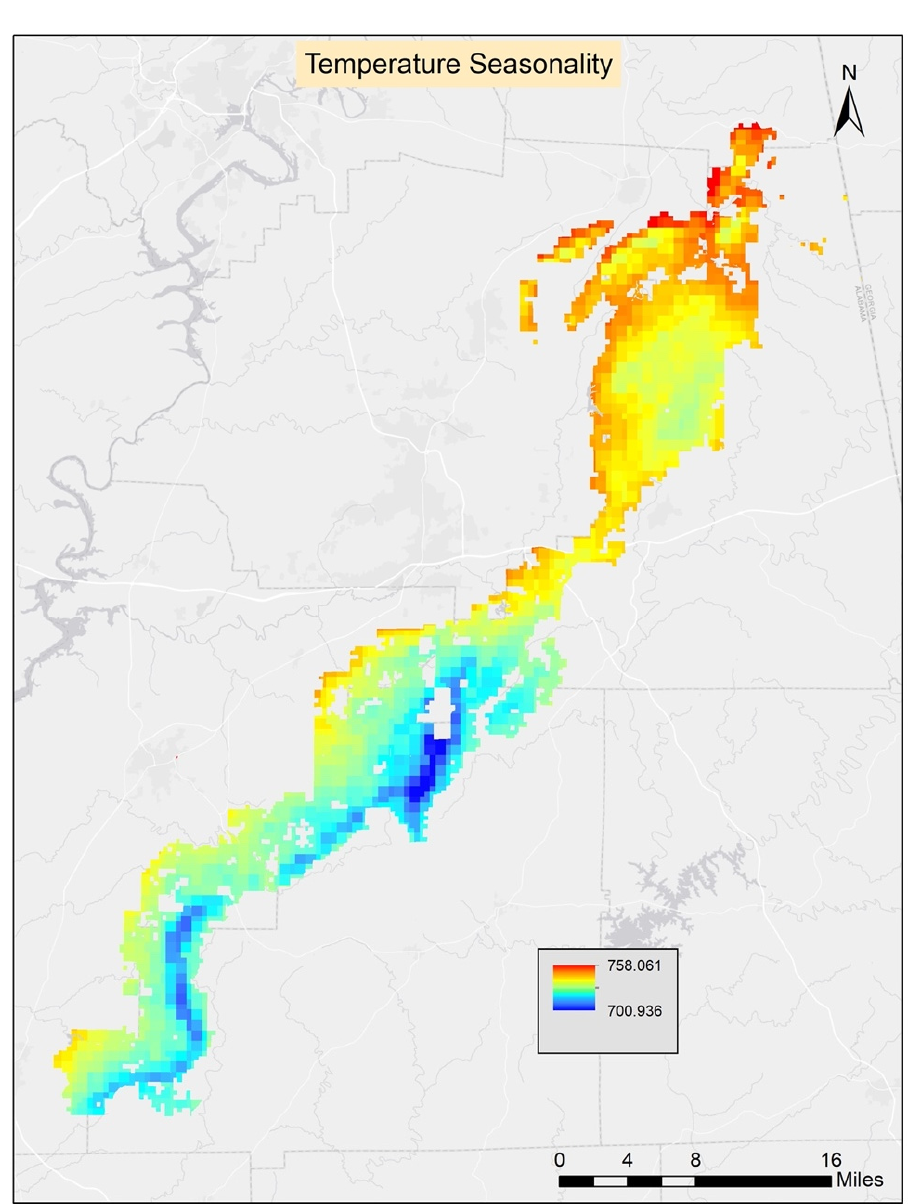
Figure A7. Temperature seasonality for Talladega National Forest.